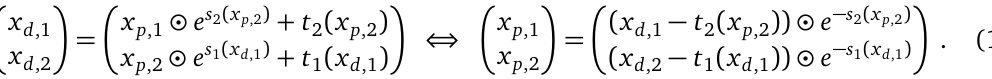
Figure 2: Structure of INN. The { x { r } are random numbers to match the phase space dimensionality. A tilde indicates d , p the INN